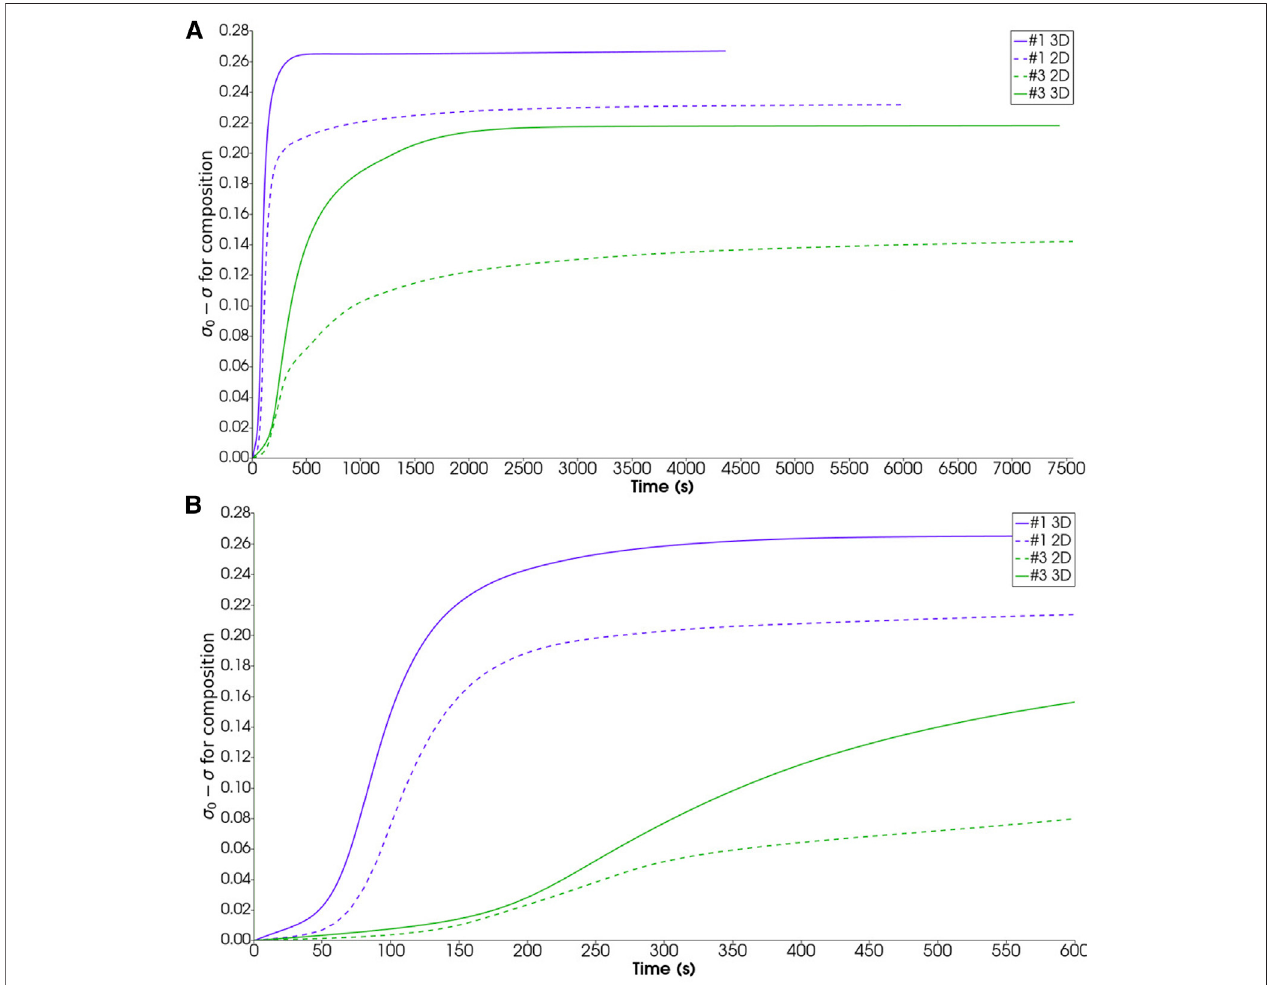
FIGURE 10 | Panel (A) : Evolution of overall compositional heterogeneities. σ is overall compositional standard deviation and σ 0 is the same quantity at time zero. Panel (B) : Zoom view of fi rst 600 s.